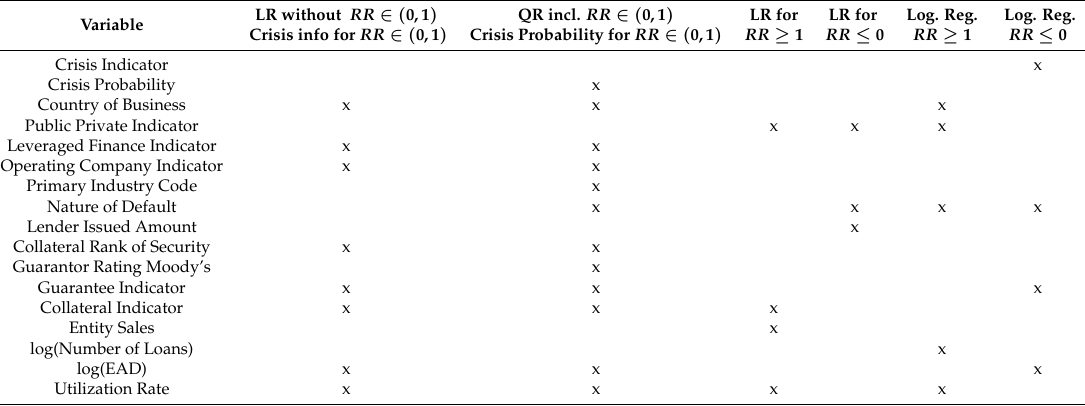
Table 3. Included attributes in the regression models (linear regressions (LR), quantile regressions (QR), and logistic regressions (Log. Reg.) of the decision